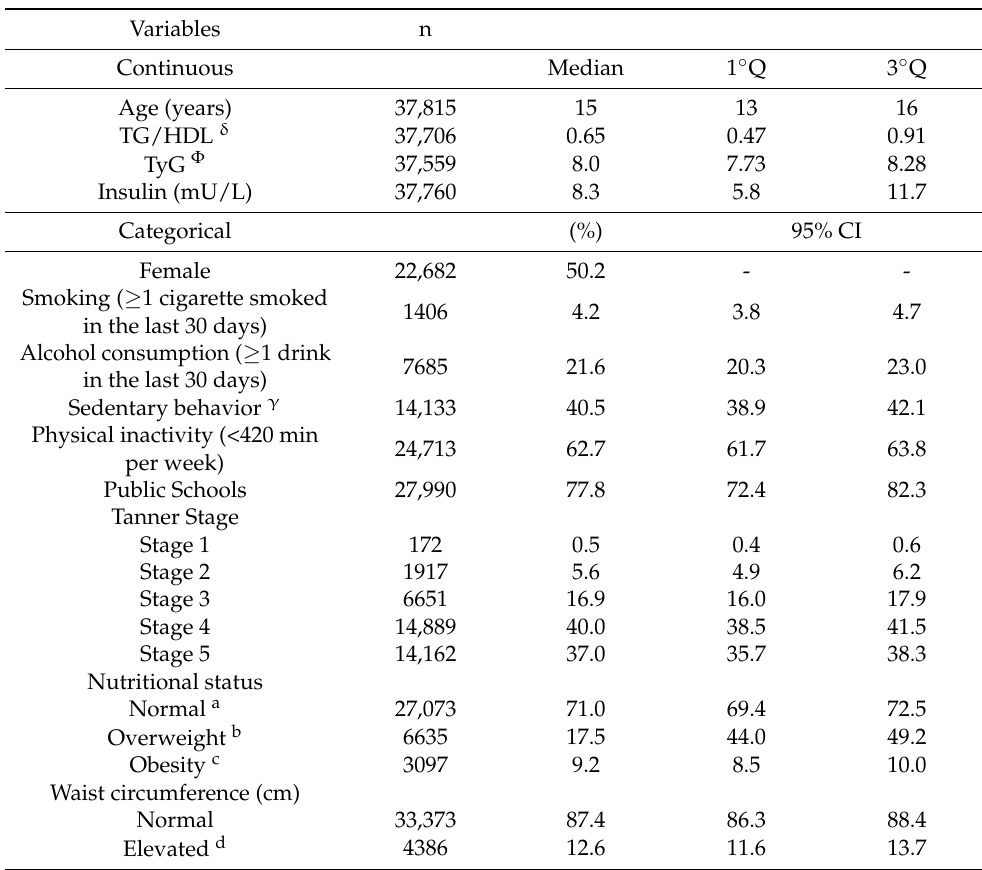
Table 1. Characteristics of 37,815 adolescents enrolled in the Study of Cardiovascular Risk Factors in Adolescents (ERICA,